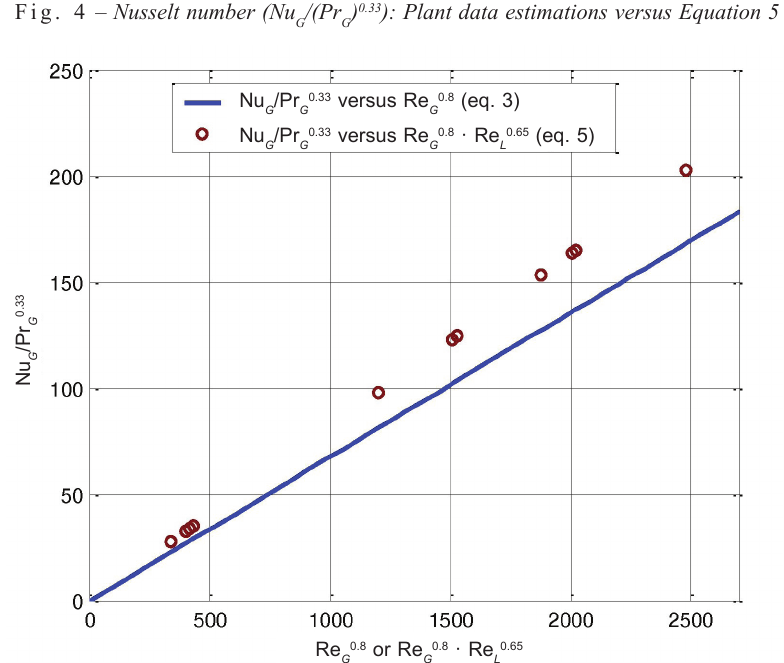
Fig. 5 – Values of the Nusselt number (Nu